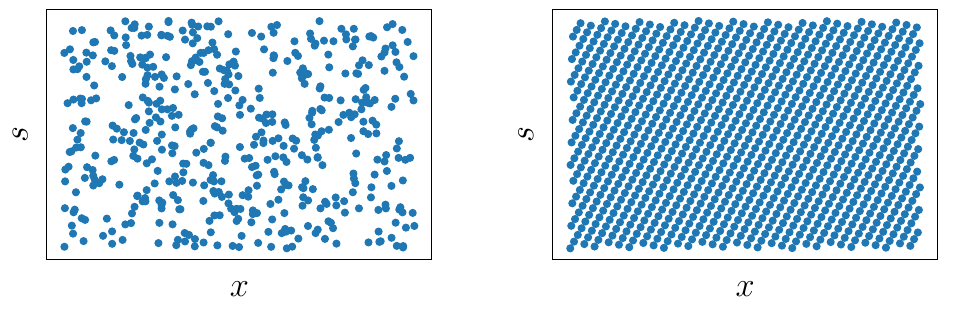
Figure 2 . Illustration of the point selection in s – x space for random (left) and Quasi-Monte Carlo (right)